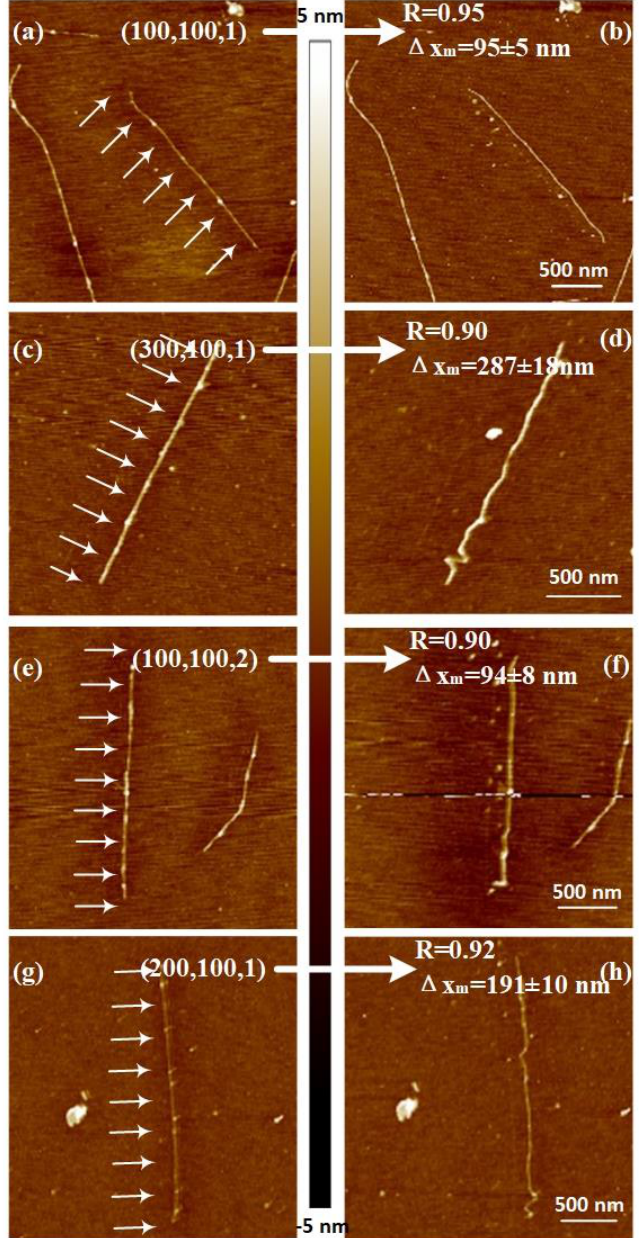
Figure 6. AFM images of CNT before and after pushing operation with different parameter combinations. The arrows in the left column of the AFM images denote the multipoint method and pushing direction. ( a ), ( c ), ( e ) and ( g ) are the AFM images before manipulating operation, ( b ), ( d ), ( f ) and ( h ) are the AFM images after manipulation with parameter combinations respectively. The vectors in the left column are the parameter combinations used in the manipulation, and R is the length ratio, Δ x m is the distance between the position of CNTs before and after manipulating. For the armchair CNTs, the effects of bending deformation on their electrical transport properties were calculated [41–43]. The transmission function was affected strongly when the bending angles were higher than 45°. Moreover, the electrical resistance increased when the bending angles were higher than 45°. However, for zigzag CNTs, the computed conductance was affected